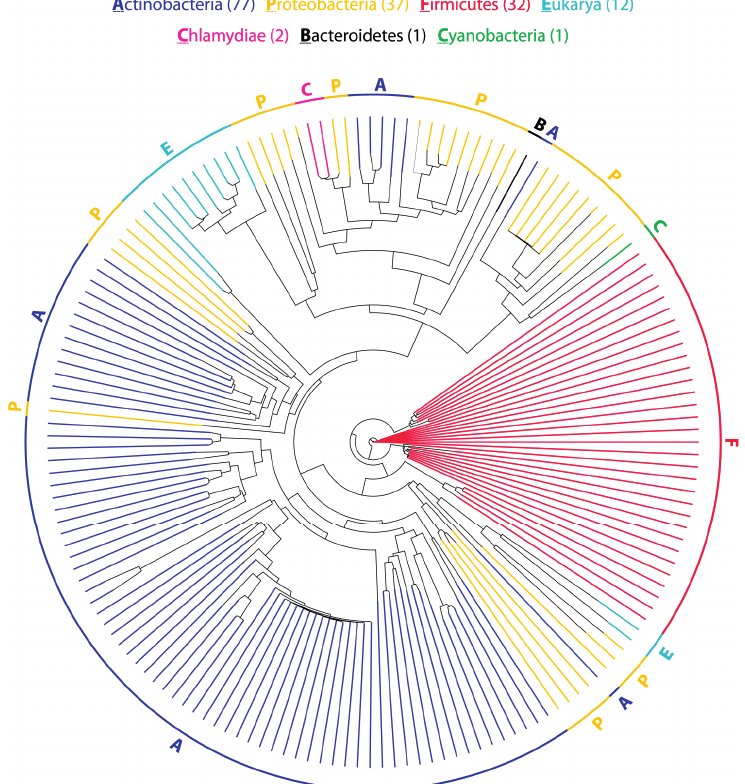
Figure 3. Phylogenetic tree representing the evolutionary relationship of 162 putative CDPSs. The tree is based on a multiple sequence alignment generated using Clustal Omega [39,40]. The optimal tree was inferred using the Neighbor-Joining method. Evolutionary distances are in units of the number of amino acid substitutions per